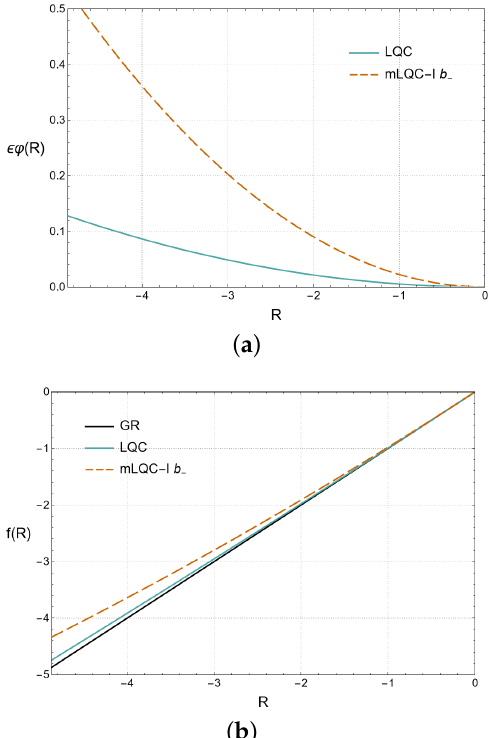
Figure 1. The plot ( a ) (Deviation, from GR, of the effective Lagrangian: a comparison between the b − branch of mLQC-I and LQC) presents the comparison between Equation (41), for the b − branch of mLQC-I (dashed dark orange line), and Equation (35), for LQC (solid blue line), with c 1 = c 2 = 0, for − 2 κρ I c ≤ R ≤ 0. Although the deviation is higher for the case of the b − branch of this modified model, both of them are dominated by the quadratic term. The plot ( b ) (Effective f ( R ) function: a comparison between the b − branch of mLQC-I, LQC, and GR) illustrates the differences between the Lagrangian density of GR (solid black line), with Λ = 0, and the effective Lagrangian densities given by Equation (36), in the case of LQC (solid blue line) and Equation (45), for the b − branch of mLQC-I (dashed dark orange line), for the interval − 2 κρ I c ≤ R ≤